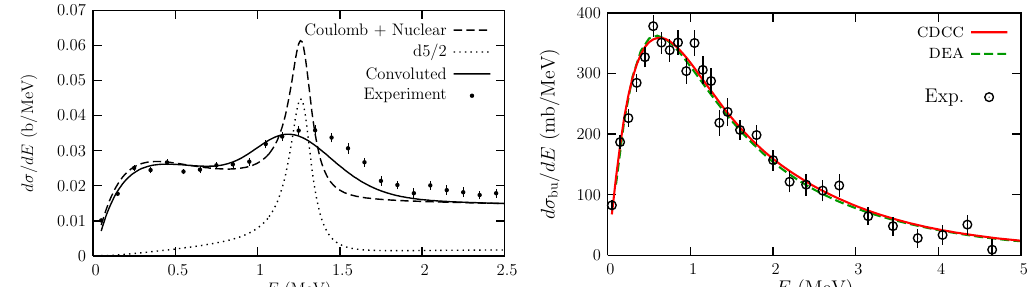
Figure 4: Cross sections for the breakup of (left) 11 Be on C at 67 MeV / nucleon and (right) 15 C on Pb at 68 MeV / nucleon, both expressed as a function of the c - n relative energy E after dissociation. Dynamical eikonal calculations [ 15, 17 ] are compared to the experimental data of (left) Ref. [ 10 ] and (right) Ref. [ 18 ] . The good agreement with experiment confirms the few-body structure of the one-neutron halo projectiles. Right figure adapted with permission from Ref. [ 17 ] . Copyright (2010) by the American Physical